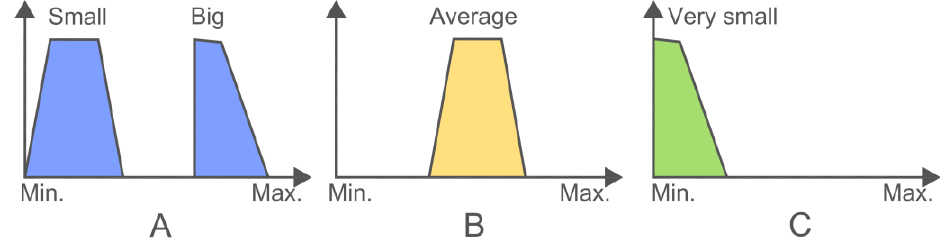
Figure 2. Example of If–Then fuzzy rule. The antecedent parameters are ( A ) and ( B ), and the consequent is ( C ).